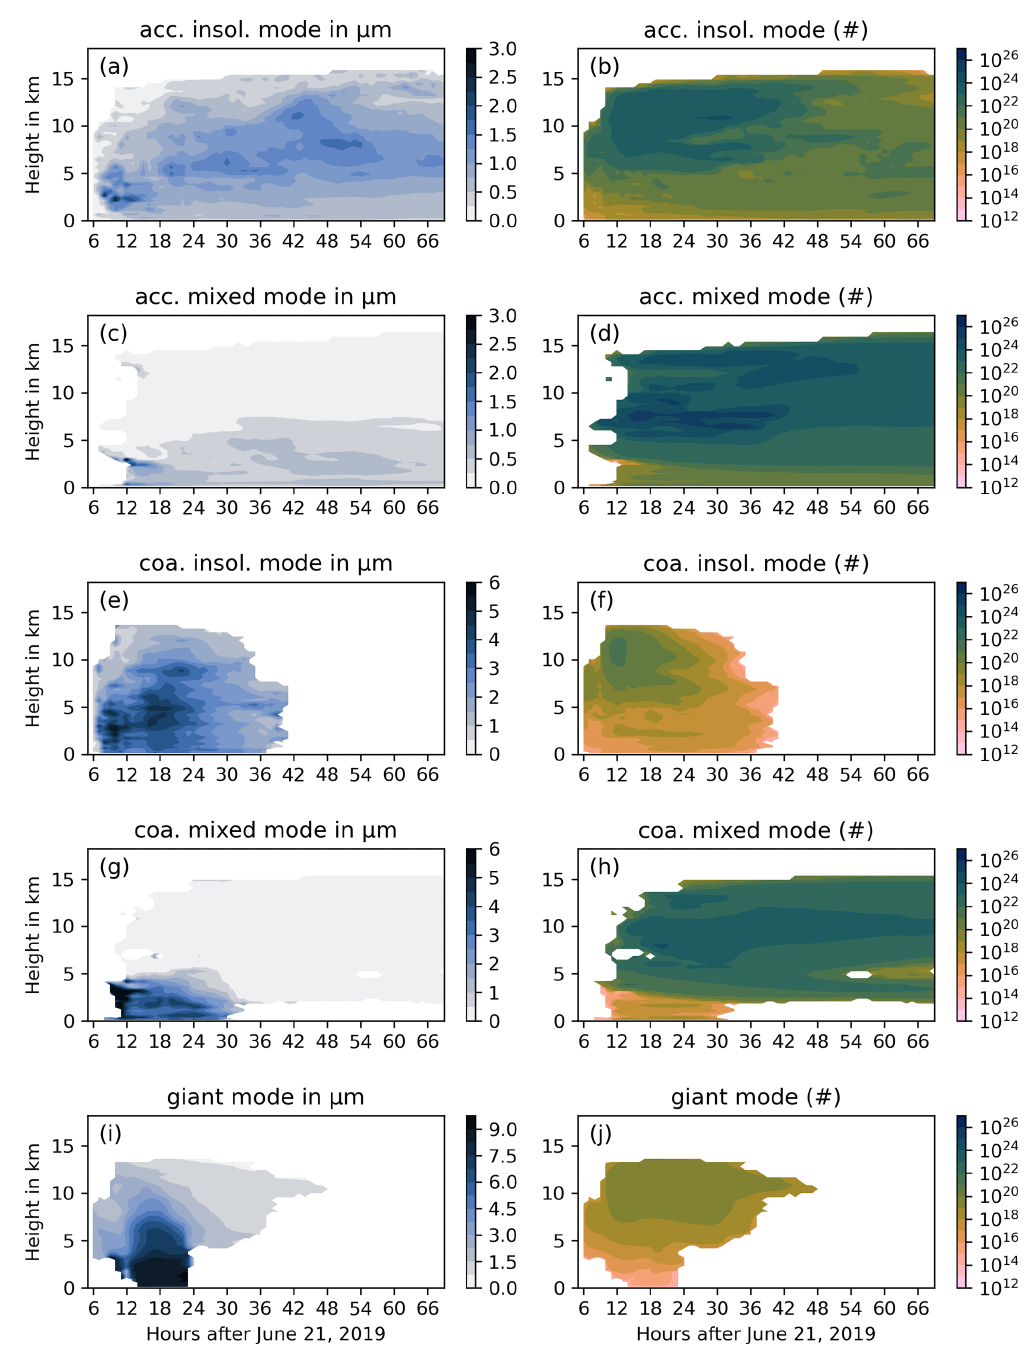
Figure A4. Horizontally averaged ash particle characteristic radius of the lognormal distribution (µm) (left, Eq. 5) and horizontal sum of the particle number (right) of the different ash modes: insoluble accumulation (a, b) , mixed accumulation (c, d) , insoluble coarse (e, f) , mixed coarse (g, h) , and giant (i, j)